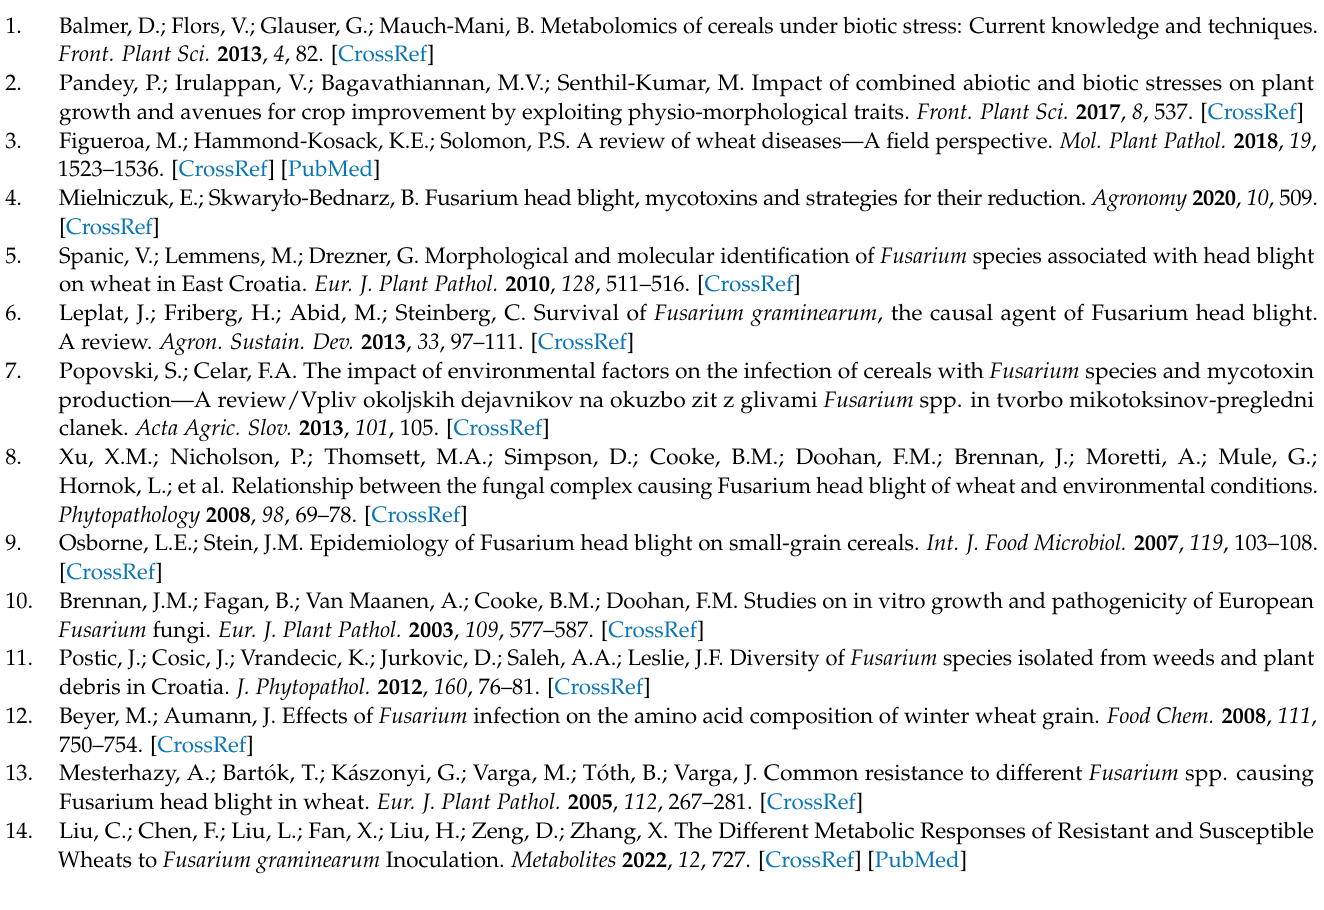
saturated fatty acids (g), small organic (carboxylic) acids (h), terpenoids (i), and saturated fatty acids (j) in control plants and plants under Fusarium treatment at experimental Tovarnik; Figure S3: Climate diagram for May 2020 at Osijek; Figure S4: Climate diagram for May 2020 at Tovarnik; Table S1: Mann– Whitney U test for 275 metabolites across different treatments at two locations together; Table S2: Area under disease progress curve (AUDPC) for general resistance at experimental locations Osijek and Tovarnik; Table S3: Results for clusters of the agglomerative hierarchical clustering; Table S4: Spearman correlation matrix of 24 wheat metabolites in grains and varietal resistance to Fusarium . Author Contributions: Conceptualization, V.S. and K.S.; methodology, V.S. and J.C.D.;